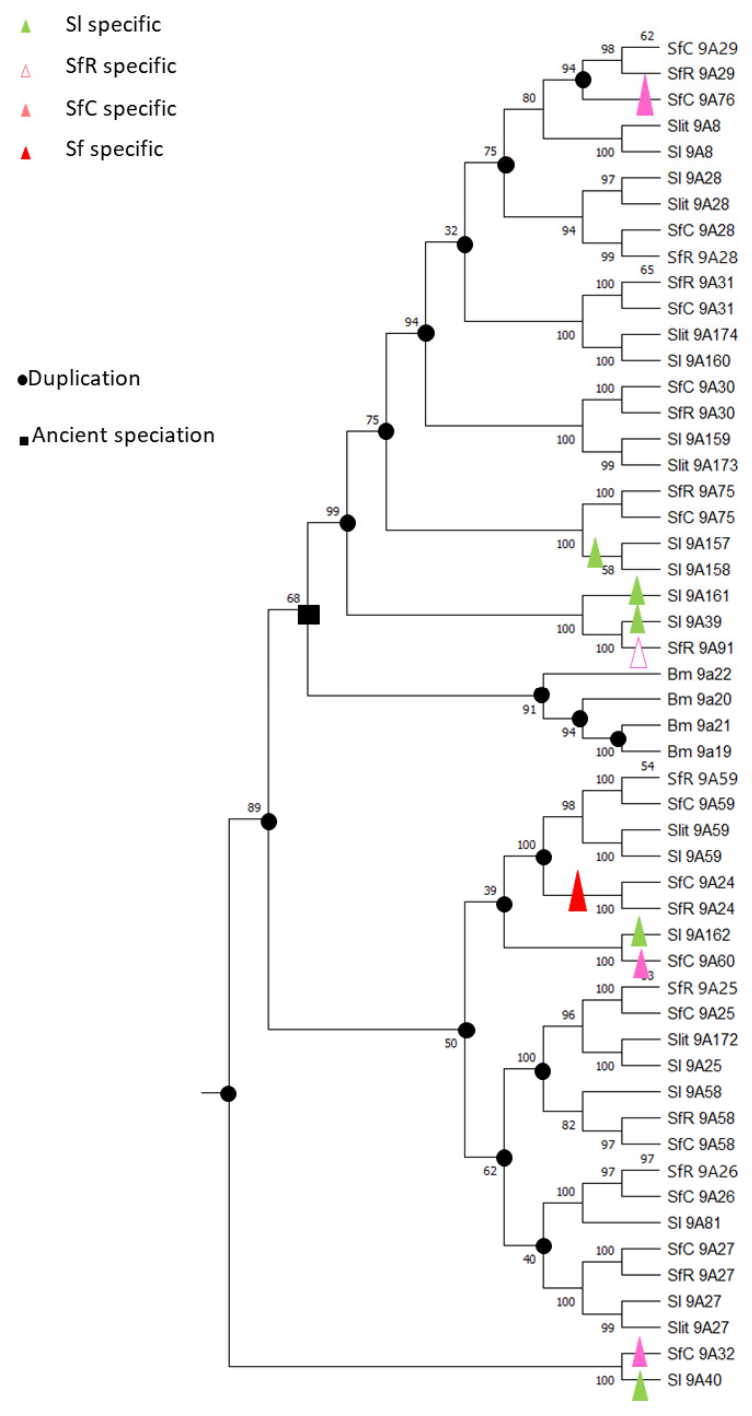
Figure 2. CYP9A subtree: ML phylogeny with bootstrap value. SfC: S. frugiperda corn strain, SfR: S. frugiperda rice strain, Sl: S. litura , Slit: S. littoralis , Bm: B. mori . Slit9A58, Slit9A81, and Slit9A40-like are missing from the tree. Black square: ancient speciation representing B. mori split from Spodoptera species. Black dot: duplication events.